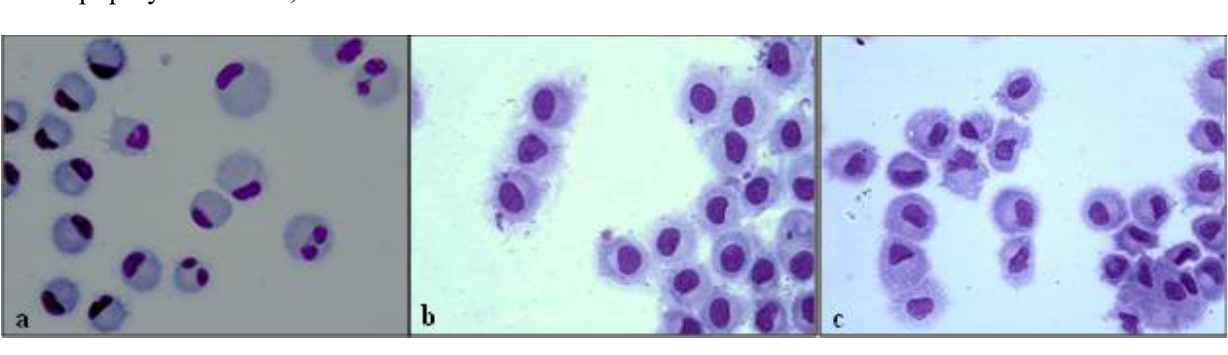
Figure 2. MoDCs at the pre-surgery timepoint. Cells were obtained at the seventh day of culture (after LPS addition) from ( a ) a healthy control; ( b ) a stage II-CRC patient; and ( c ) a stage III-CRC patient. The morphological analysis was performed by light microscopy (magnification, 100×) on MoDCs previously stained with May-Grünwald-Giemsa. A representative experiment is shown. MoDCs: monocyte-derived dendritic cells; LPS: lipopolysaccharide; CRC: colorectal